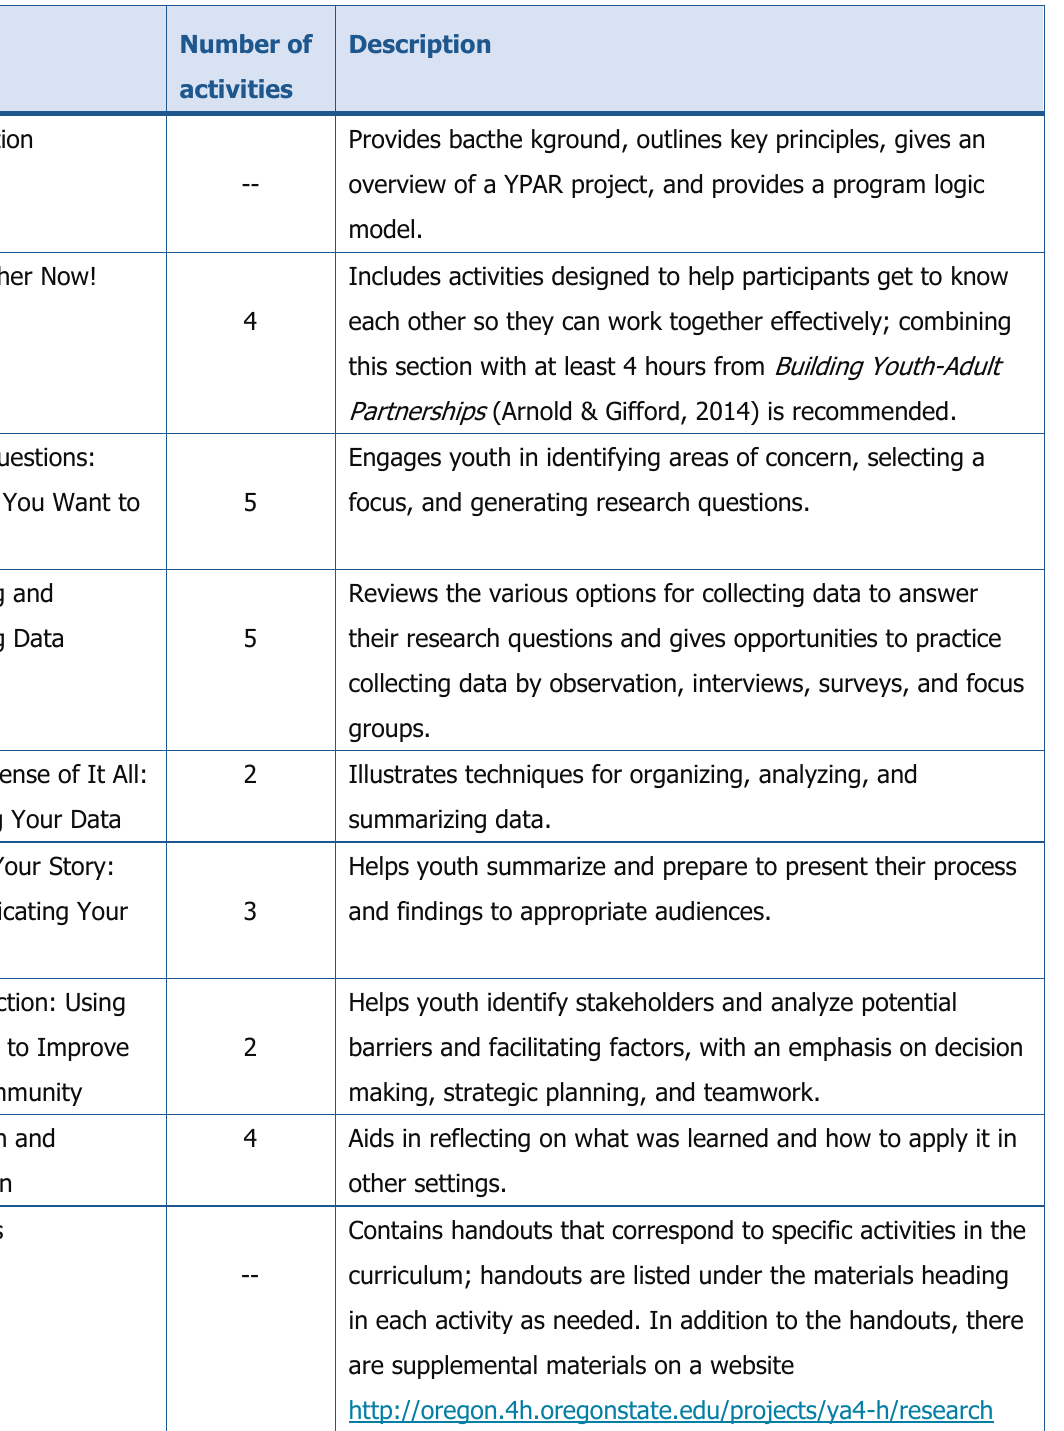
Table 2. Description of Youth Participatory Action Research Curriculum Contents (Arnold & Gifford,